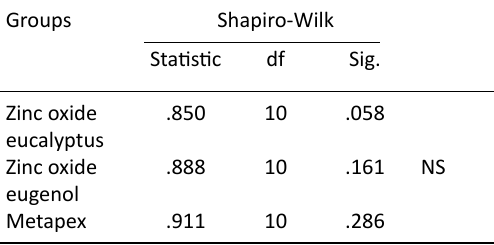
Table 1. Normality test of Streptococcus